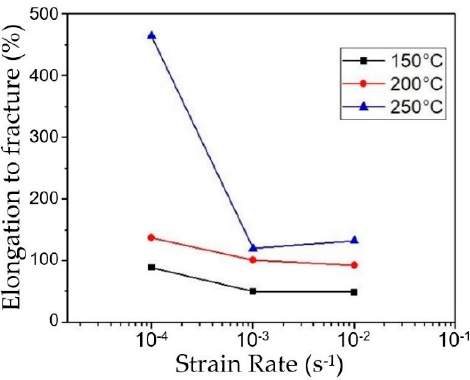
Figure 7. Elongation to fracture as a function of strain rate at different temperatures.